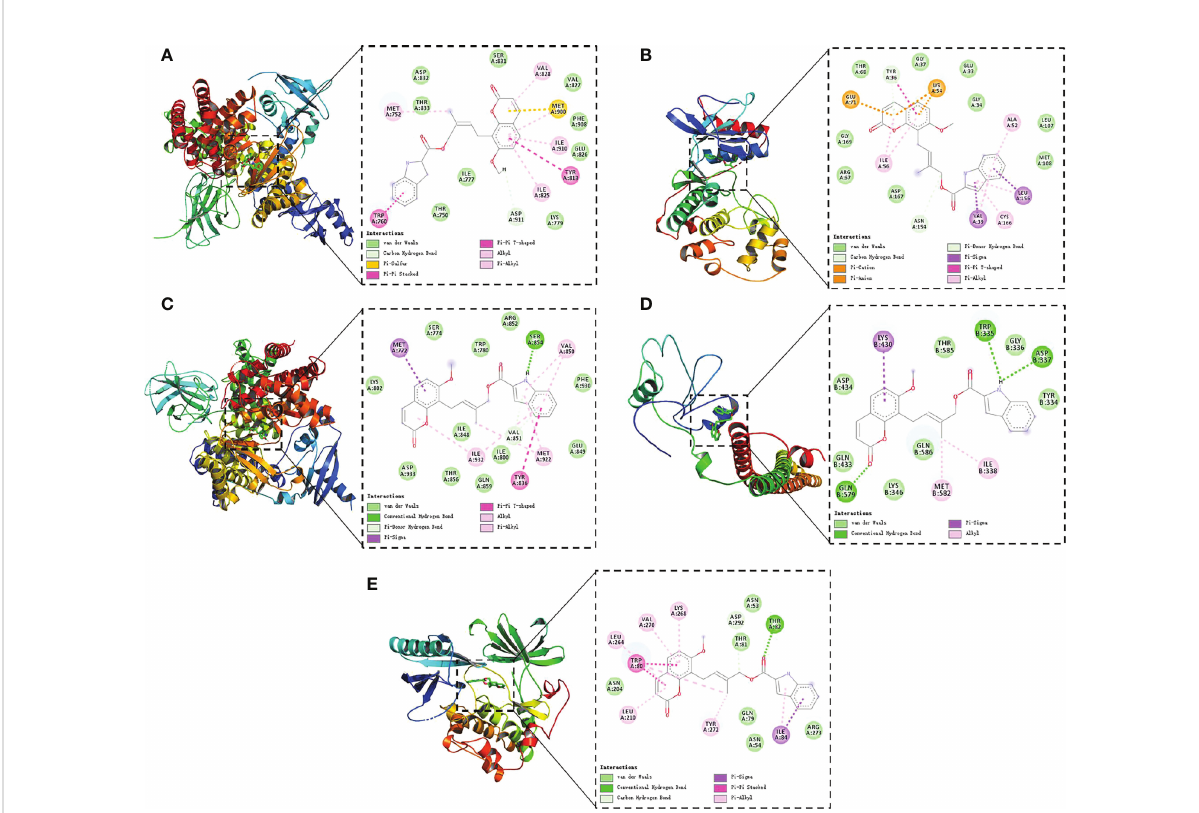
FIGURE 9 Molecular models of 4m binding to AKT1 (A) , PIK3CD (B) , PIK3CA (C) , PIK3R1 (D) , and MAPK1 (E) . The green dotted lines show the hydrogen bonds; the pink full lines show the p – p